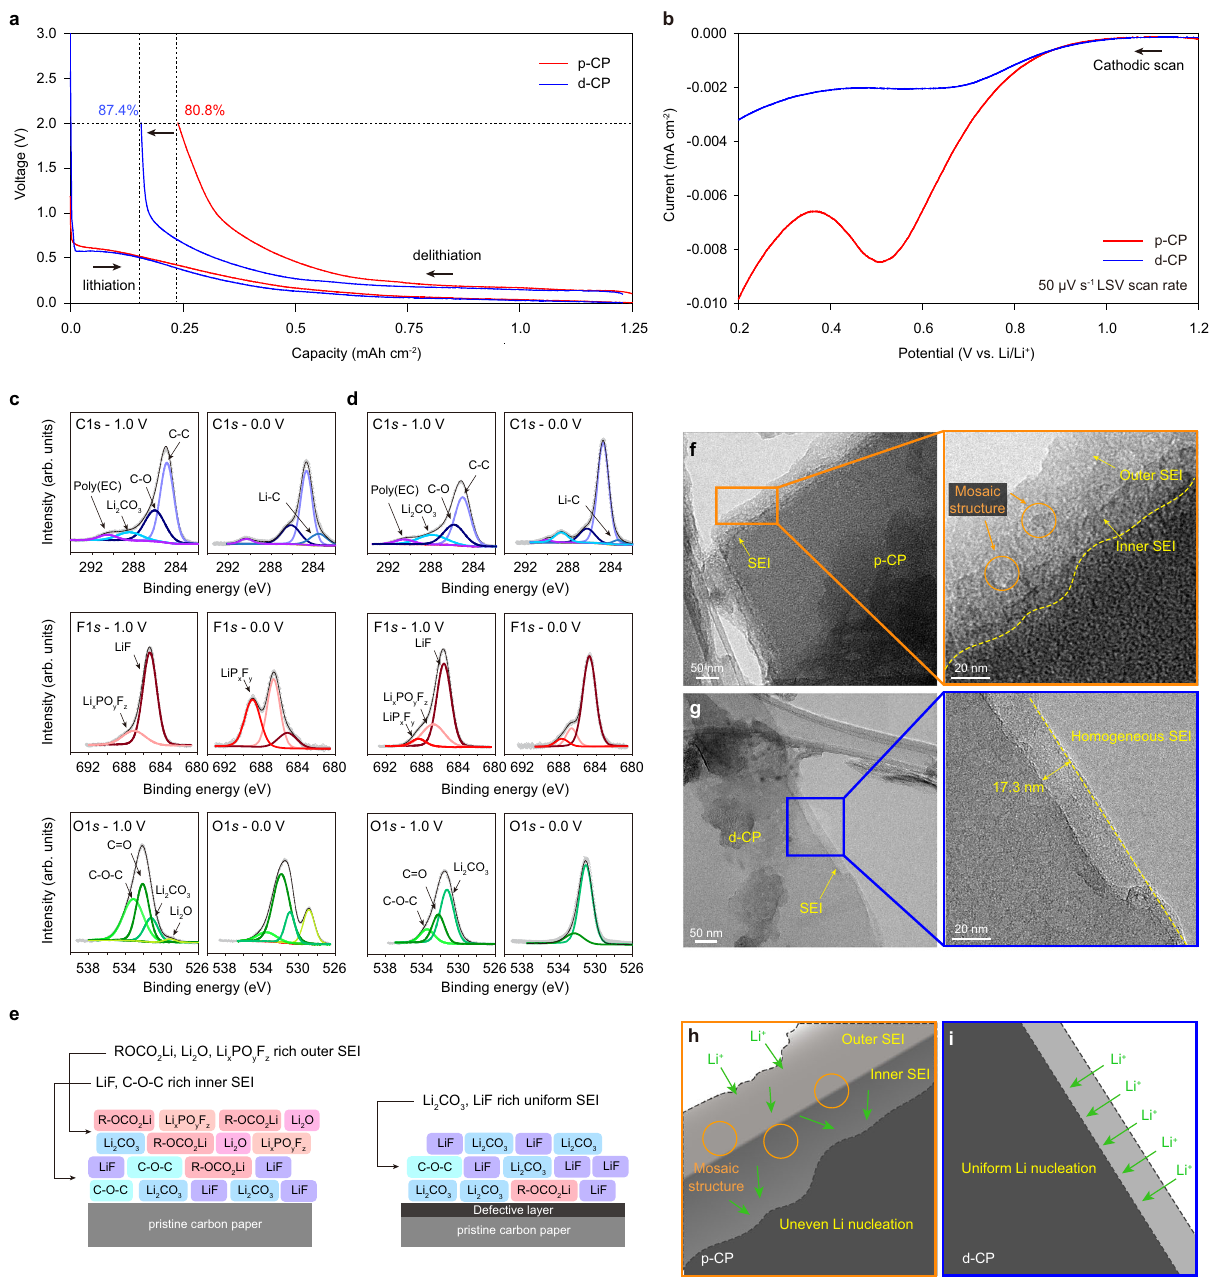
Fig. 3 SEI formation on the multivacancy carbon current collector. a Galvanostatic lithiation – delithiation curves for Li||p-CP and Li||d-CP cells in the range of 0.0 to 2.0 V at 0.1 mA cm − 2 for the quanti fi cation of irreversible capacity at the fi rst cycle due to electrolyte decomposition at the current collector. b Current density from electrolyte decomposition based on the active surface area of the current collector (Supplementary Fig. 2a, b) during the LSV measurement (cathodic scan) at a 50 μ V s − 1 scan rate for the Li||p-CP and Li||d-CP half-cells. c , d Ex situ XPS analysis of the SEI layer on p-CP ( c ) and d-CP ( d ). The remaining spectra were taken after galvanostatic reduction at 0.1 mA cm 2 down to 1.0 V (inner SEI), and the right spectra to 0.0 V (outer SEI). The binding energy was calibrated with the C – C bond peak of 285 eV in the C 1 s spectra. e Suggested SEI composition on p-CP (left) and d-CP (right). f , g TEM images of the SEI layers for p-CP ( f ) and d-CP ( g ) after galvanostatic reduction to 0.0 V. h , i Schematic representation of the SEI microstructure formed on p-CP ( h ) and d-CP ( i